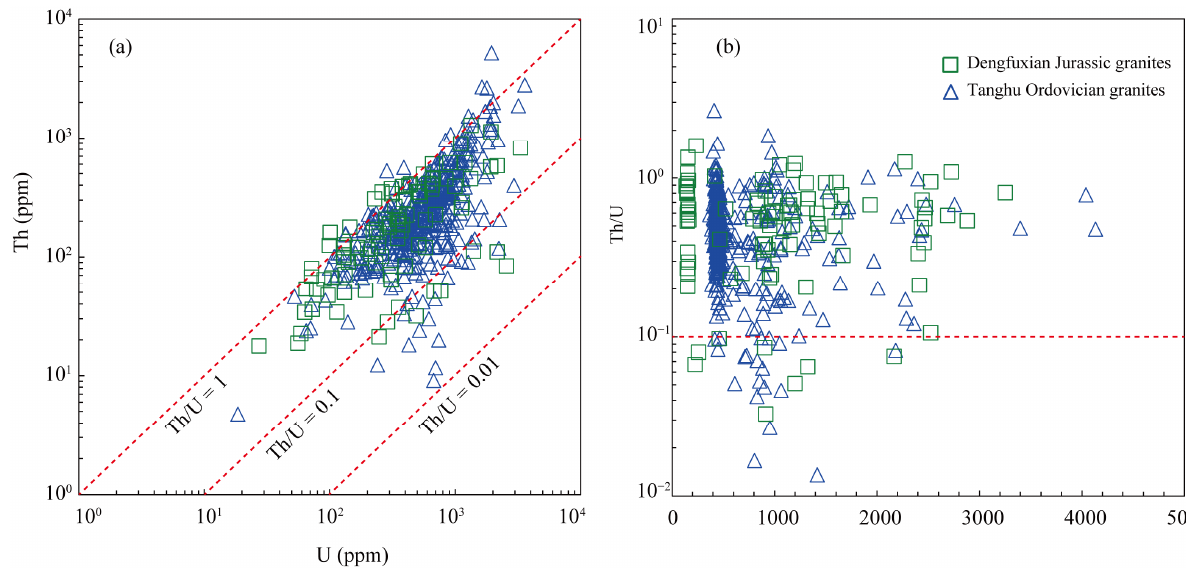
Figure 5. U versus Th ( a ) and age versus Th/U diagrams ( b ) of zircons from the Dengfuxian and Tanghu granites.